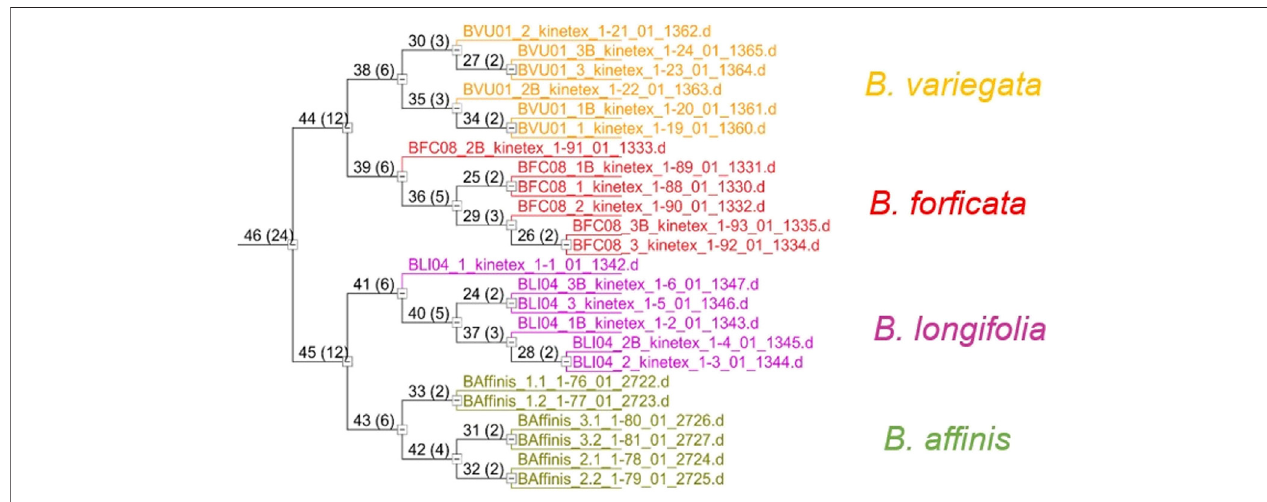
FIGURE 5 | Hierarchical clustering analysis of the 4 studied Bauhinia species.